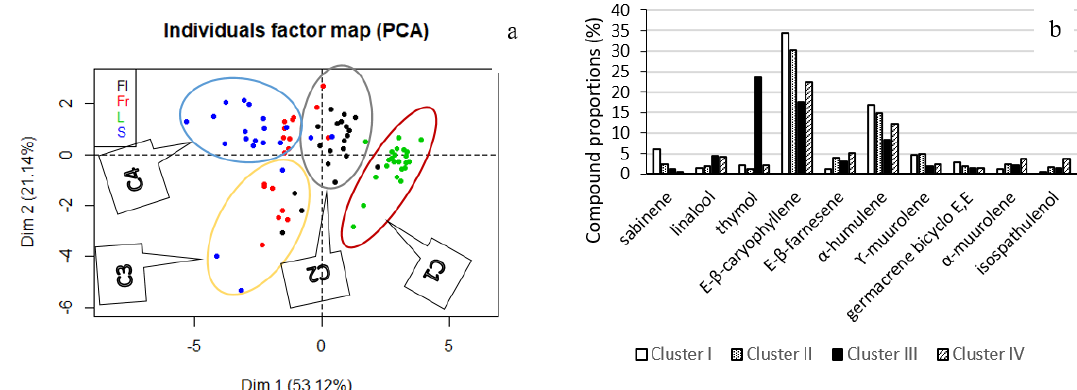
Figure 3. ( a ) Principal Component Analysis distribution of the essential oil samples of L. camara and clustering. ( b ) Proportions of the principal components of L. camara essential oil samples of Clusters I, II, III, and IV.